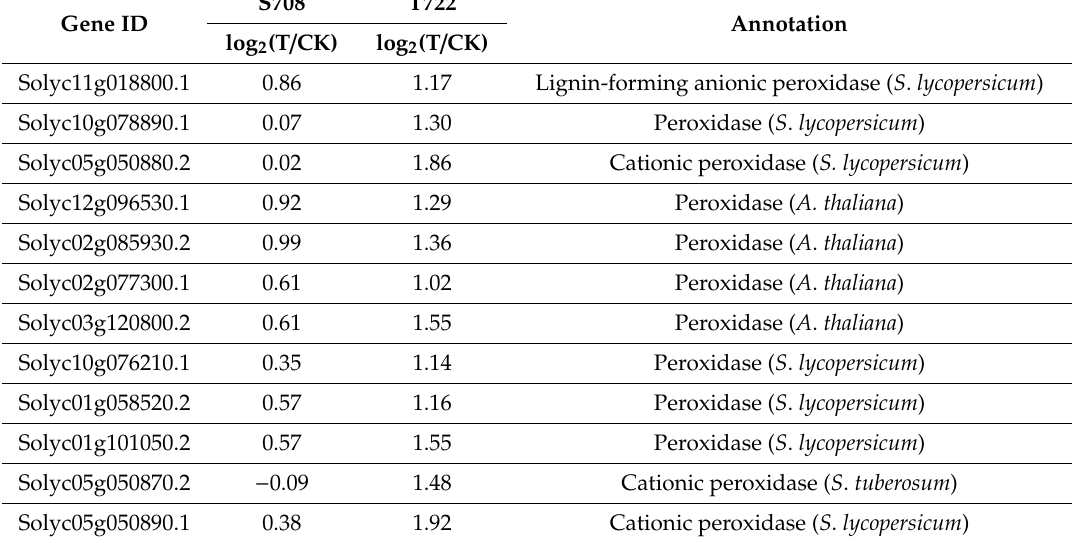
Table 5. List of selected genes induced by sub-optimal temperature in the significantly enriched KEGG pathway “phenylpropanoid biosynthesis” only in T722. S708 and T722 tomato cultivars grown under normal (CK, 25 / 18 ◦ C) and sub-optimal temperature conditions. Values are the log 2 ratio (T / CK) for genes more than 1 or less than − 1 with FDR < 0.05 as the threshold to judge the significance of gene expression di ff erence between the two groups.